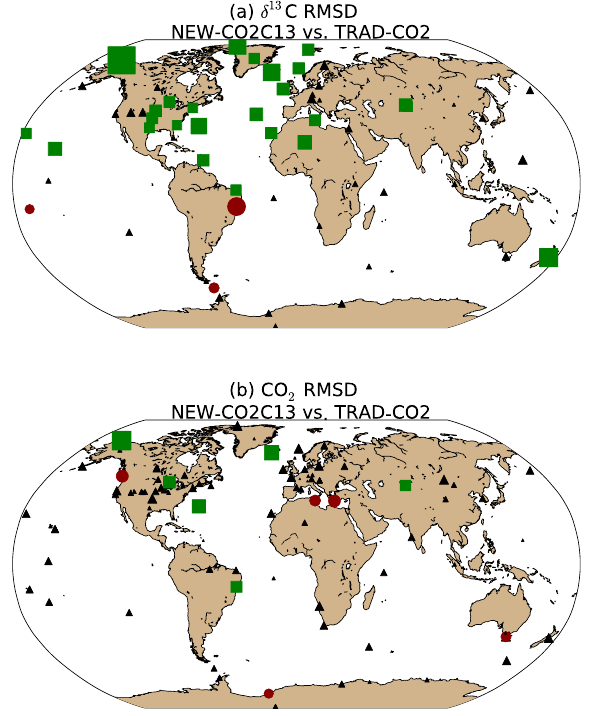
Figure 7. A comparison of the relative performance of inversion techniques for the period 2001 through 2006 based on the ratio of the model–data (a) δ 13 C root mean square difference (RMSD) of NEW − CO2C13 to δ 13 C RMSD of TRAD − CO2, and (b) CO 2 RMSD of NEW − CO2C13 to CO 2 RMSD of the TRAD − CO2 in- version. A ratio lower than 1.0 indicates a higher accuracy of the NEW − CO2C13 inversion technique; green sites indicate a ratio less than or equal to 0.95, red sites indicate a ratio greater than or equal to 1.05, and sites where the difference in respective RMSD is less than 0.05 are given in black. The size of each symbol is a mea- sure of the relative performance of NEW − CO2C13 in comparison to TRAD − CO2. The larger the symbol the more the ratio of RMSD differs from